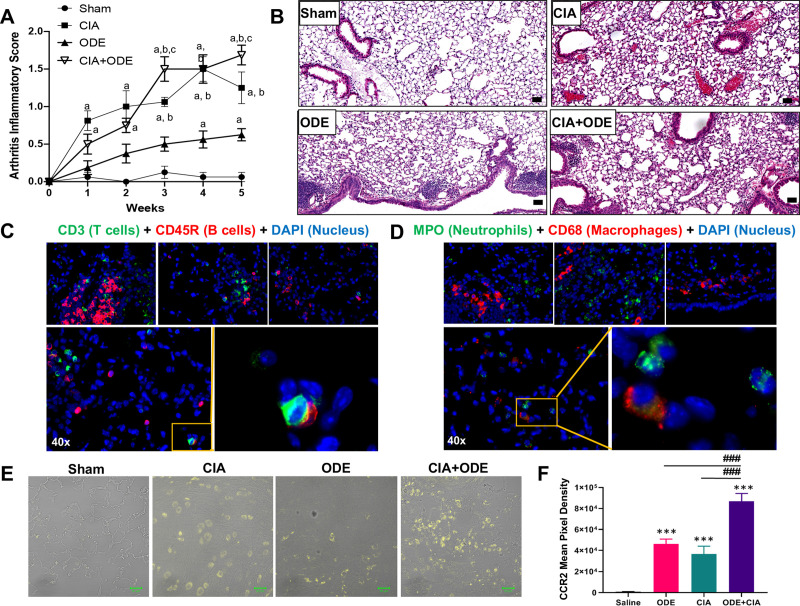
Agriculture (swine) exposure-related Organic Dust Extract (ODE) induced airway inflammation coupled with Collagen Induced Arthritis (CIA) model.(A) Line graph depicts mean with SE bars of arthritis inflammatory score at respective time points from treatment groups. Statistical difference versus sham denoted as “a” (p<0.05); versus ODE denoted “b” (p<0.05); versus CIA denoted as “c” (p<0.05) as determined by two-way ANOVA. N = 8 mice/group from 3 independent studies. (B) Representative H&E-stained lung section from each treatment group at 10 X magnification with line scale (100 pixels). Representative images of lungs of CIA+ODE at 40x (parenchyma and peribronchiolar/perivascular regions), immunostained with CD3 (T cells) and CD45R (B cells) (C), and myeloperoxidase (MPO, neutrophils) and CD68 (macrophages) (D). Zoomed images highlight B-cell-T-cell interaction (C) and macrophages with neutrophils (D). CCR2+ inflammatory monocytes were increased with ODE and CIA treatment conditions in murine lungs. (E) Representative image of CCR2 expression (yellow) of lung tissue from each treatment group. (F) Bar graph depicts mean with standard error bars of CCR2 staining (N = 5/group). Statistical difference ***p<0.001 vs. saline/sham control and ###p<0.001 denoted by line between groups.